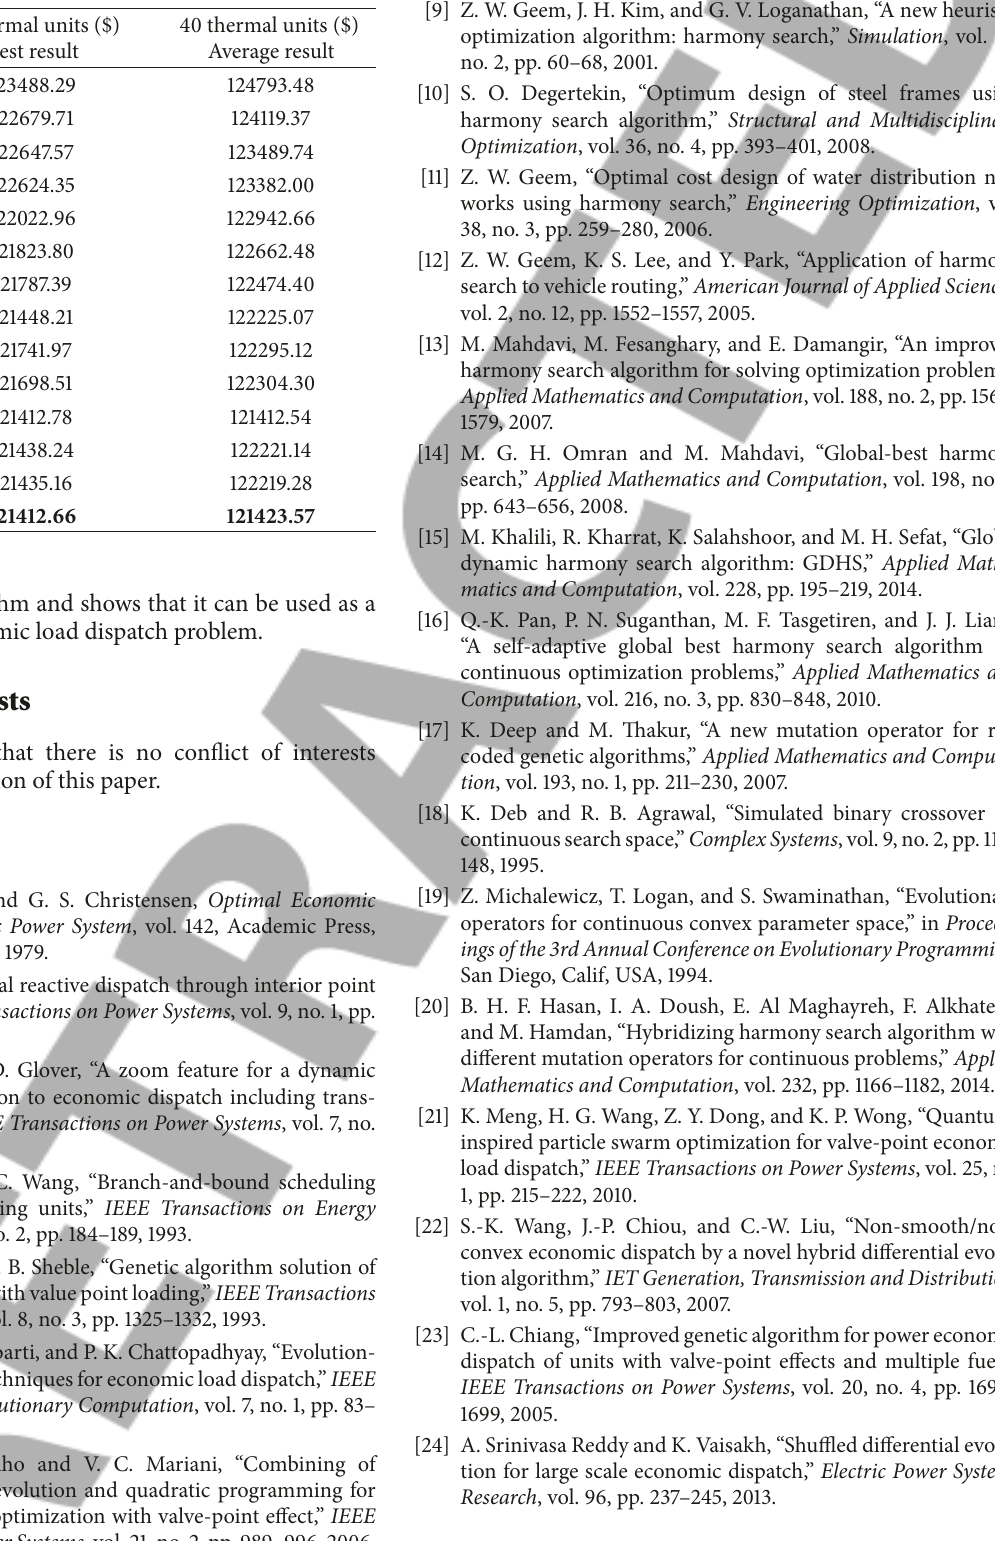
Table 11: Best result comparison with different algorithms for 40 thermal units’